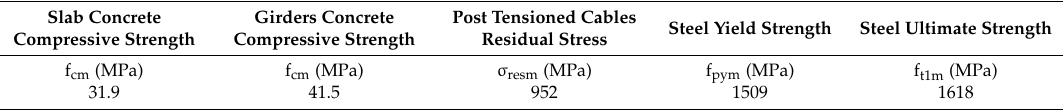
Table 1. Materials properties of the Alveo Vecchio viaduct.